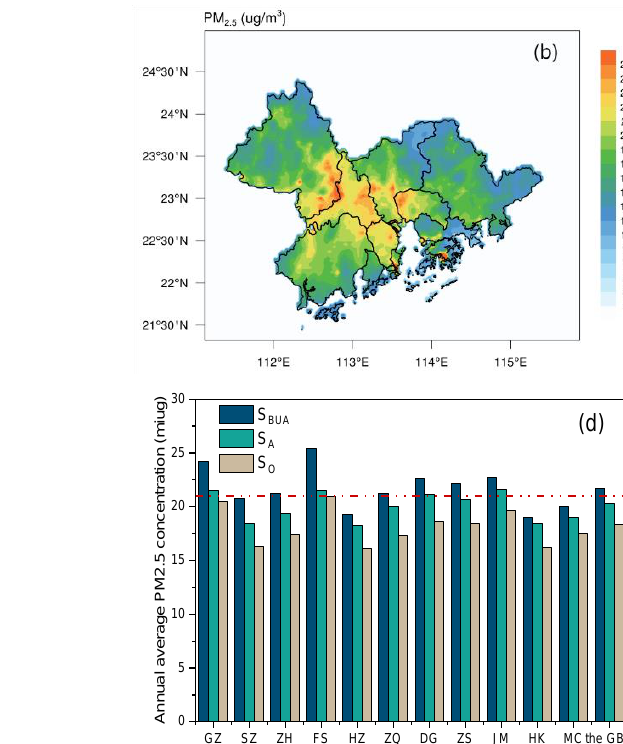
12 of 18 Figure 5. Industrial air pollutant emission reduction benefits in 2025: ( a ) Emission reductions from eight measures in S BAU ; ( b ) Emission reductions from five additional measures in S A compared to